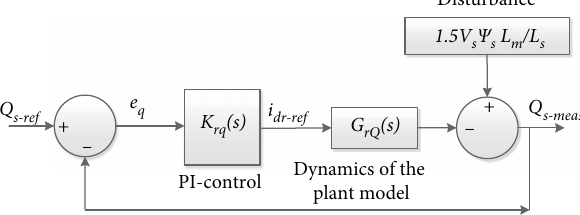
Figure 11: The PI reactive power control loop structure of the RSC. Figure 12: Droop‐based direct power vector control structure for RSC of the VSPS (reactive power control loop).